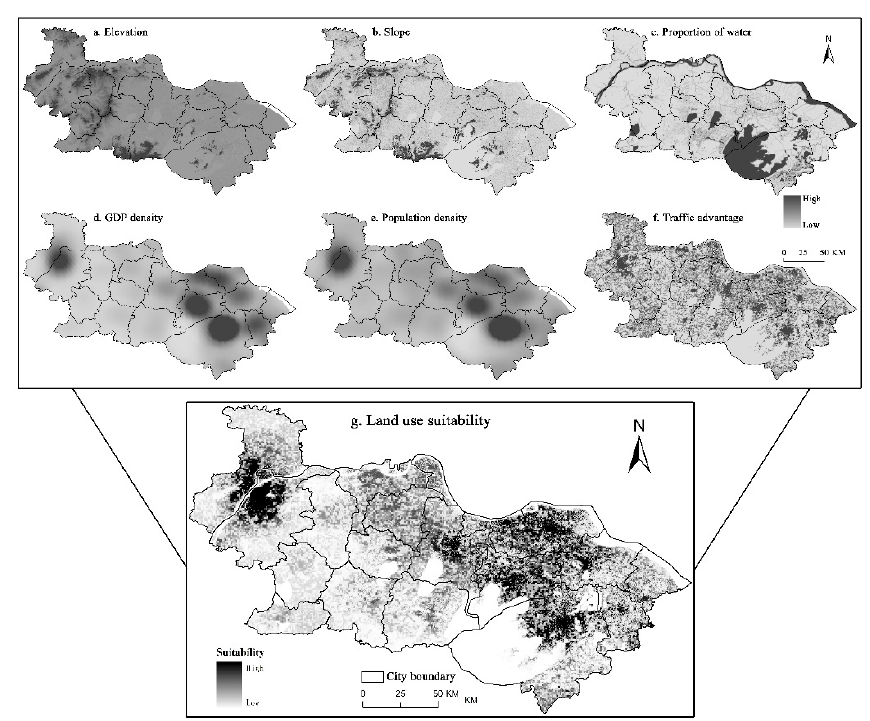
Figure 4. The distribution patterns of six indicators and LUS .